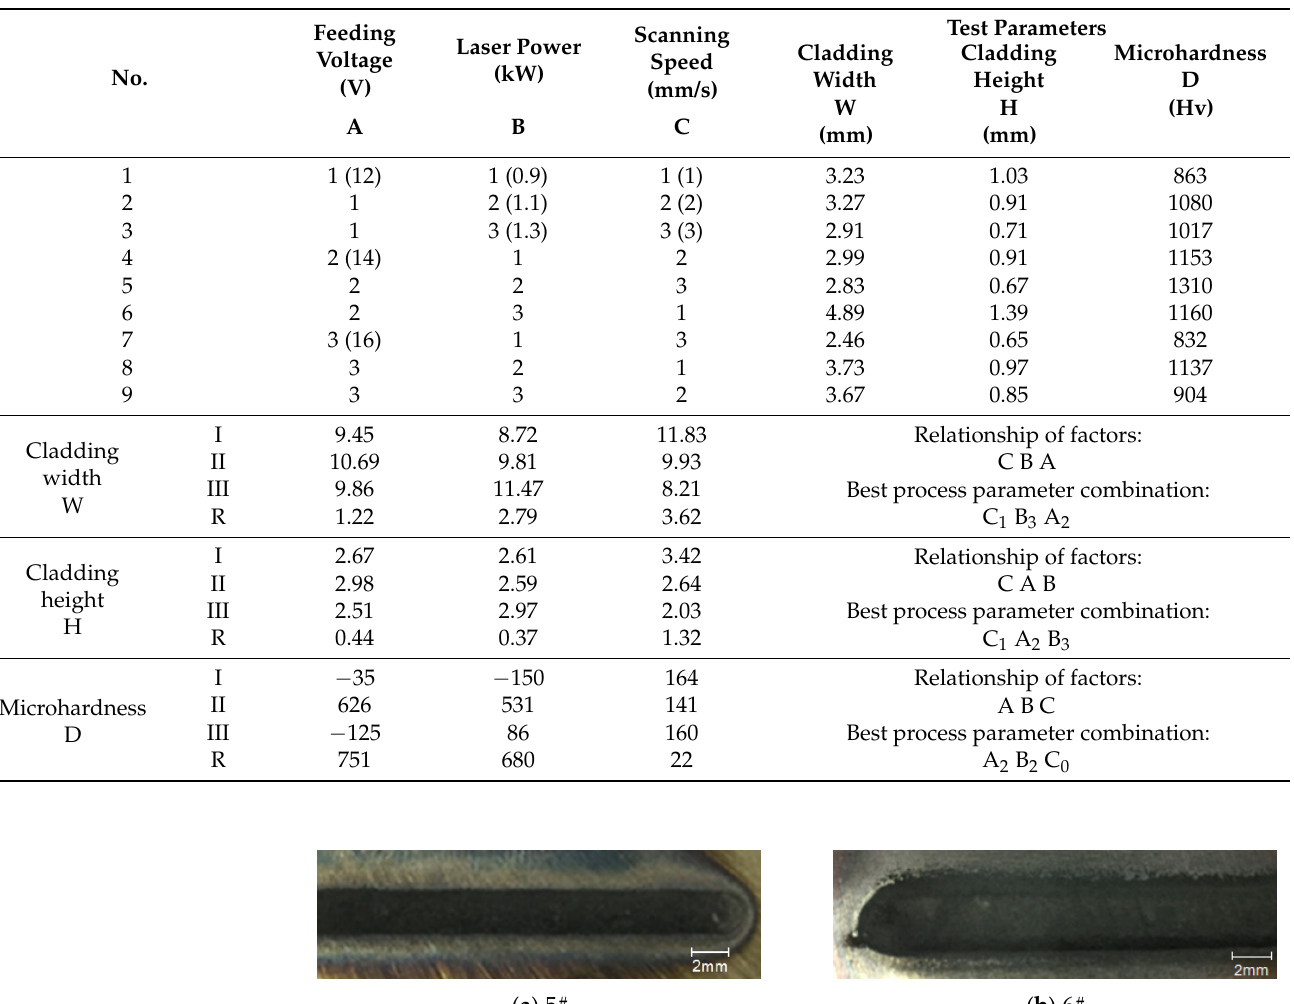
Table 4. Orthogonal experimental table and results.